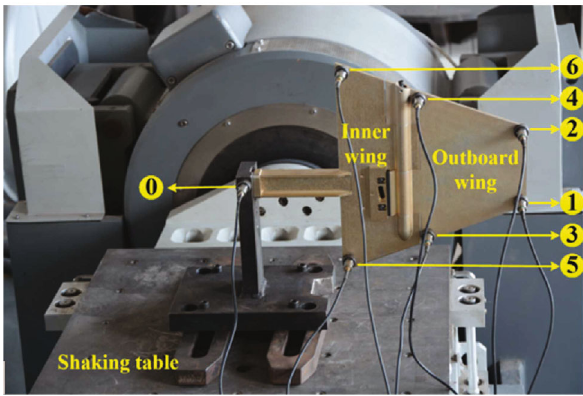
Figure 2: Photo of the experimental